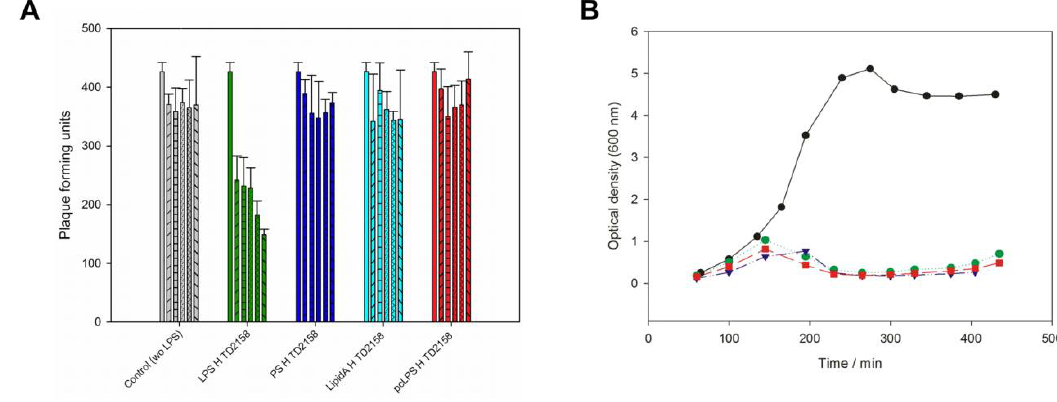
Figure 2. Phage HK620 in vivo infection assays. ( A ) In vivo plaque forming assay after incubation of 4.5 × 10 3 pfu mL −1 HK620 particles with 25 µg mL −1 LPS from E. coli H TD2158 LPS (green). After 0,